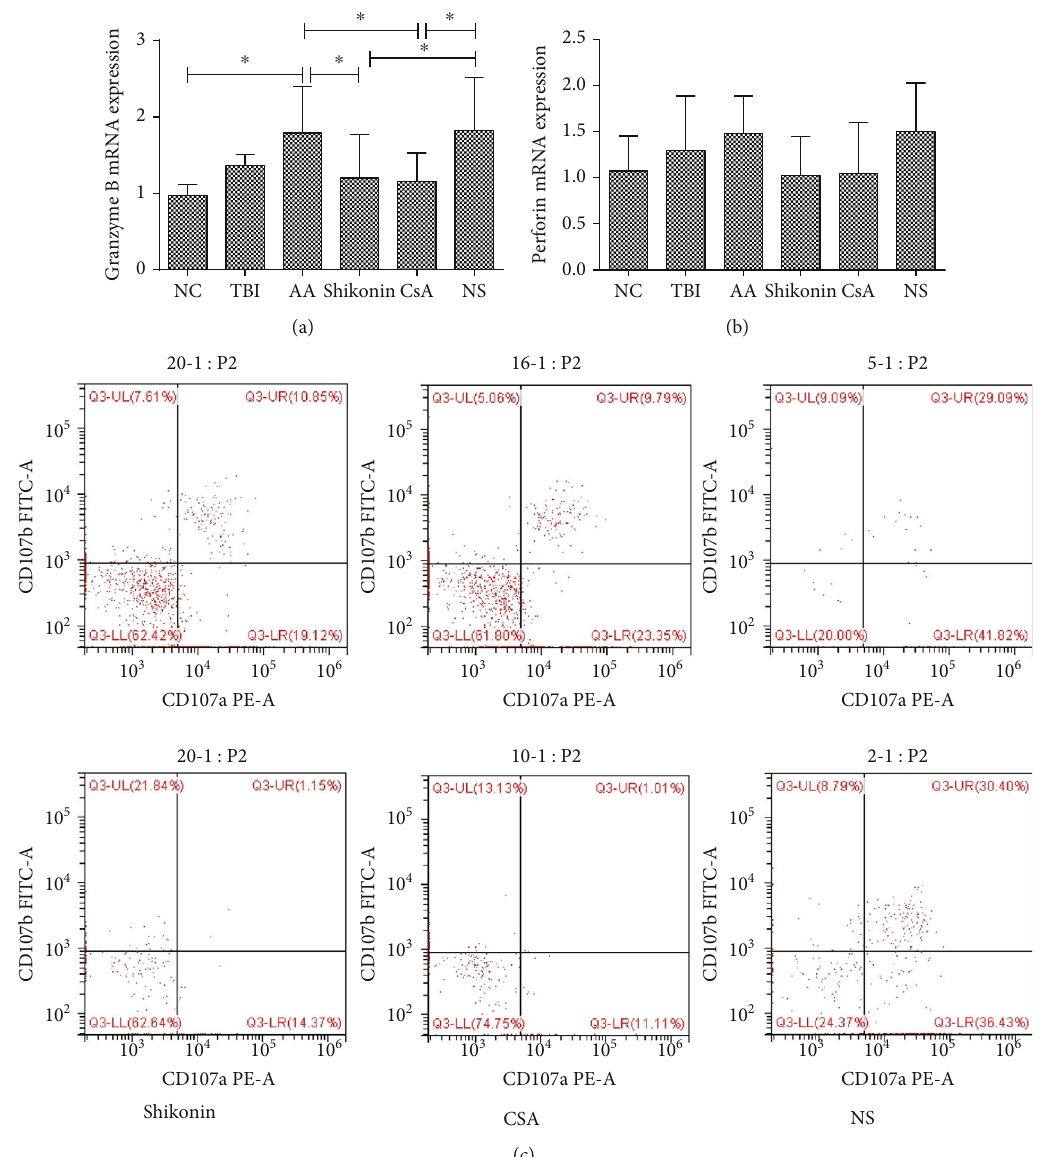
Figure 4: (a) The granzyme B mRNA expression of CD8+ cells in the AA group was signi fi cantly higher than that in the NC group, while those in the shikonin and CsA groups were signi fi cantly decreased compared with the AA and NS groups ( p < 0 : 05 ). (b) The level of perforin mRNA expression in CD8+ cells did not show a statistically signi fi cant di ff erence among the six groups ( p > 0 : 05 ). (c) The ratio of CD107a+CD8+/CD8+ cells and CD107b+CD8+/CD8+ cells in the AA group was increased compared with that in the NC group, while those in the shikonin and CsA groups were signi fi cantly decreased compared with that in the NS group ( p < 0 : 05 ). AA: aplastic anemia ( n = 17 ); TBI: total body irradiation ( n = 10 ); NC: normal control ( n = 10 ); shikonin ( n = 10 ); CsA: cyclosporin A ( n = 10 ); NS: normal saline ( n = 10